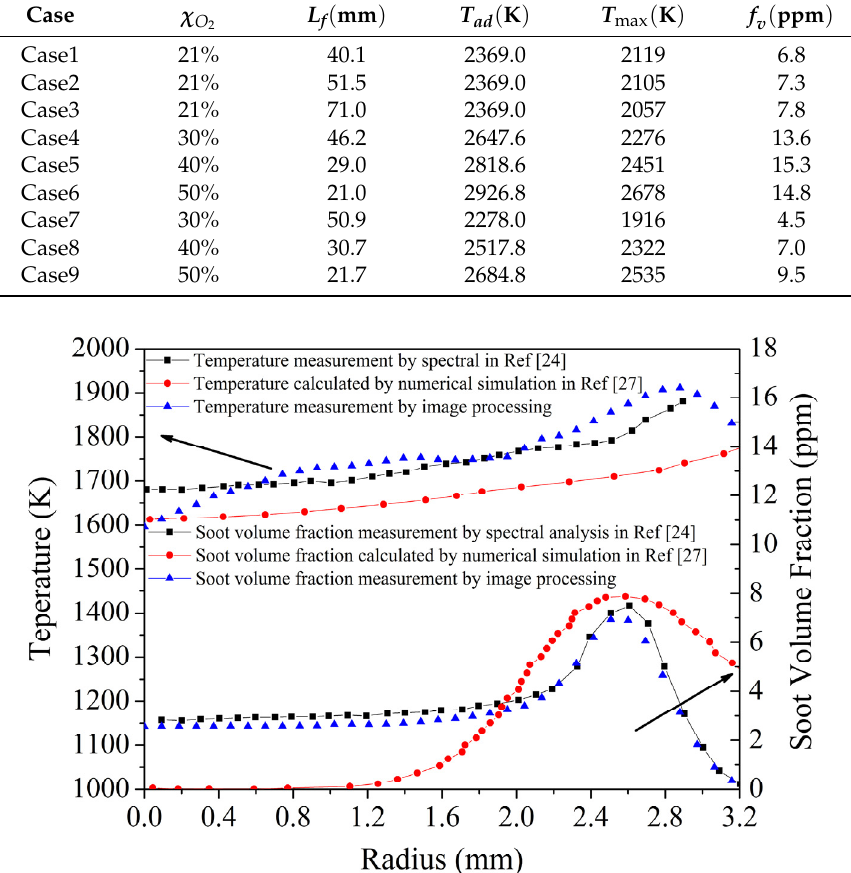
Figure 13. Comparison of temperature and soot volume fraction profiles at flame height z = 30 mm of case 3 with the results in Ref. [24,28].